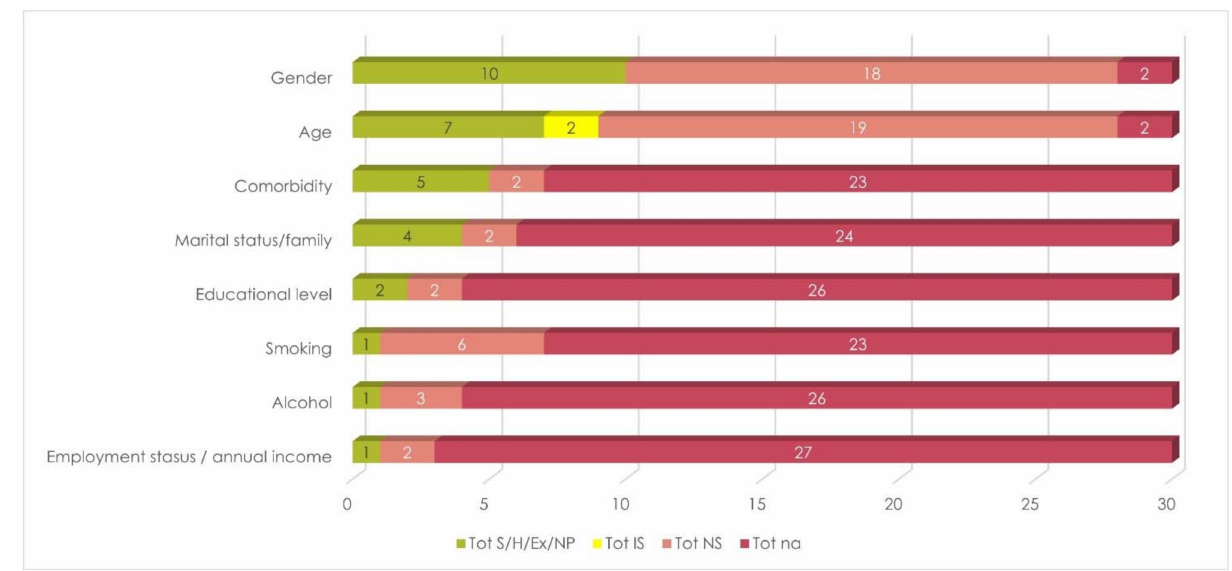
Figure 4. Overall stratification by SDG variables. Legend to Figure 4: Ex = excluded; H = homogeneous; IS = incom- plete/inadequate stratification; na = not available; NP = not present; NS = not stratified; S = stratified. On average, only 5.0 (SD, 4.0) DT variables were considered by each included study,